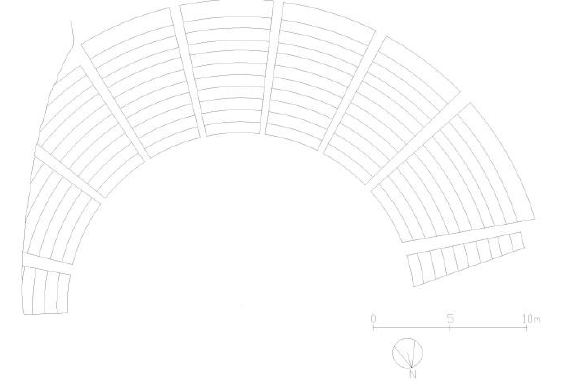
Figure 5 - Rhinoceros: the point cloud in the various projections